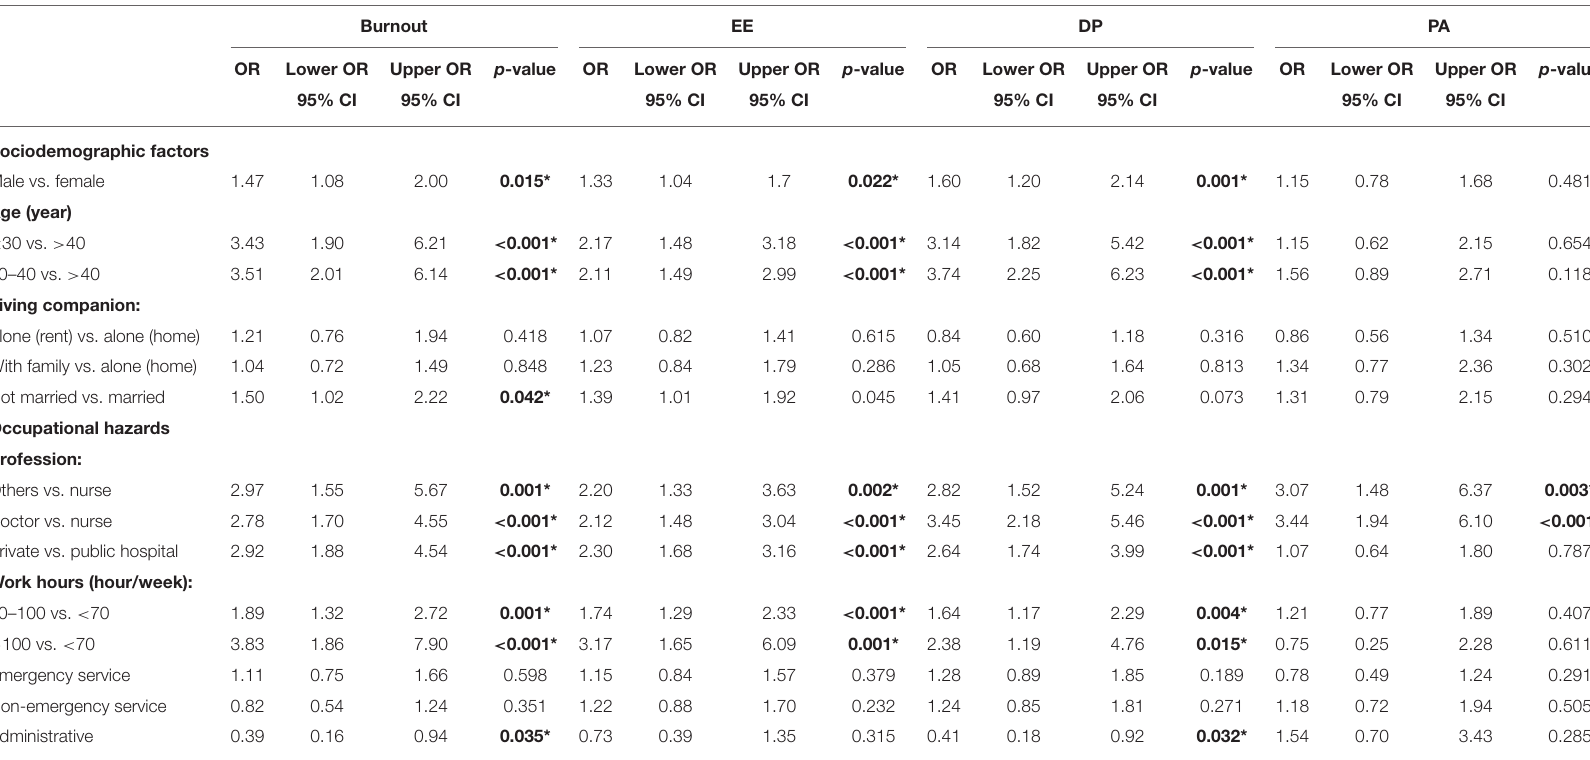
TABLE 3 | The logistic regression odds ratio ( OR ) and 95% confidence interval ( CI ) of burnout and each of the MBI subscale scores compared by sociodemographic and occupational hazards. Burnout EE DP PA OR Lower OR Upper OR p -value OR Lower OR Upper OR p -value OR Lower OR Upper OR p -value OR Lower OR Upper OR p -value 95% CI 95% CI 95%